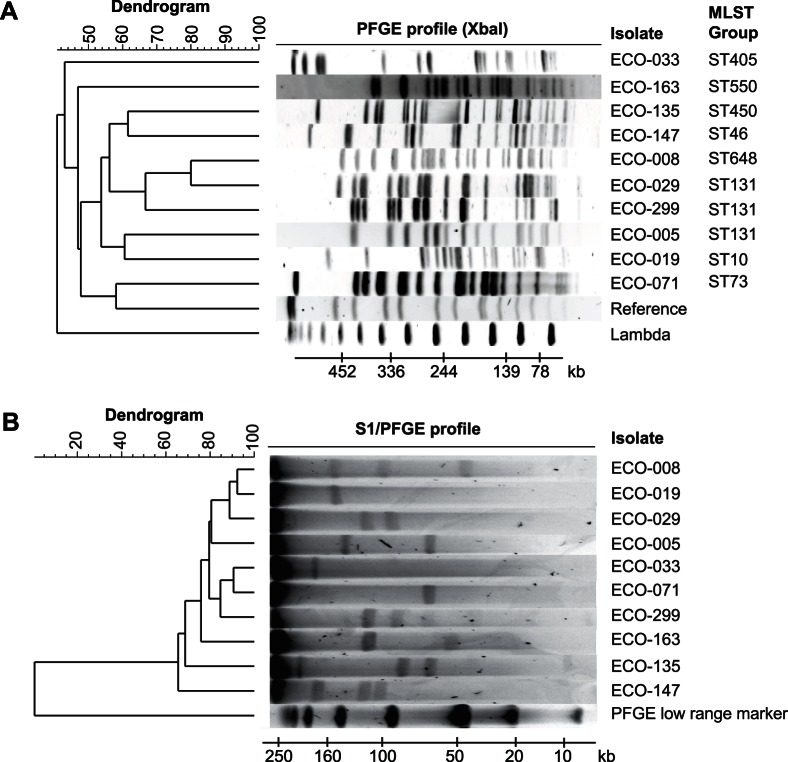
Epidemiologic strain typing and S1/PFGE plasmid profiles.(A) Total E. coli DNA digested with the restriction enzyme Xbal and analysed using pulse-field gel electrophoresis (PFGE). Fingerprints were analysed using BioNumerics v. 6.6. The name of the isolate and the multilocus sequence type (MLST) is indicated to the right (under ‘MLST Group’). The dendrogram to the left shows sample similarity by UPGMA clustering of PFGE patterns. The bottom scale-bar refers to size of PFGE bands in kilobases. (B) S1/PFGE analysis of extrachromosomal DNA (e.g., plasmid and phage DNA) of the ten isolates.